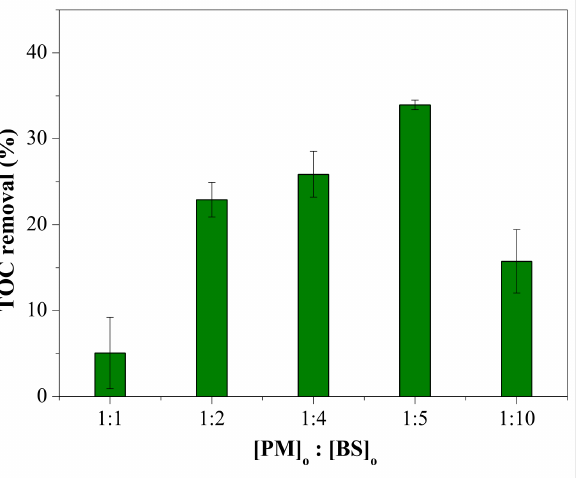
Figure 2. Removal of TOC by PM/BS process with different molar ratios of PM to BS. ((HA) o = 3 mg L − 1 , t = 30 min and (PM) o :(BS) o = 1:1–1:10). Duplicated samples were